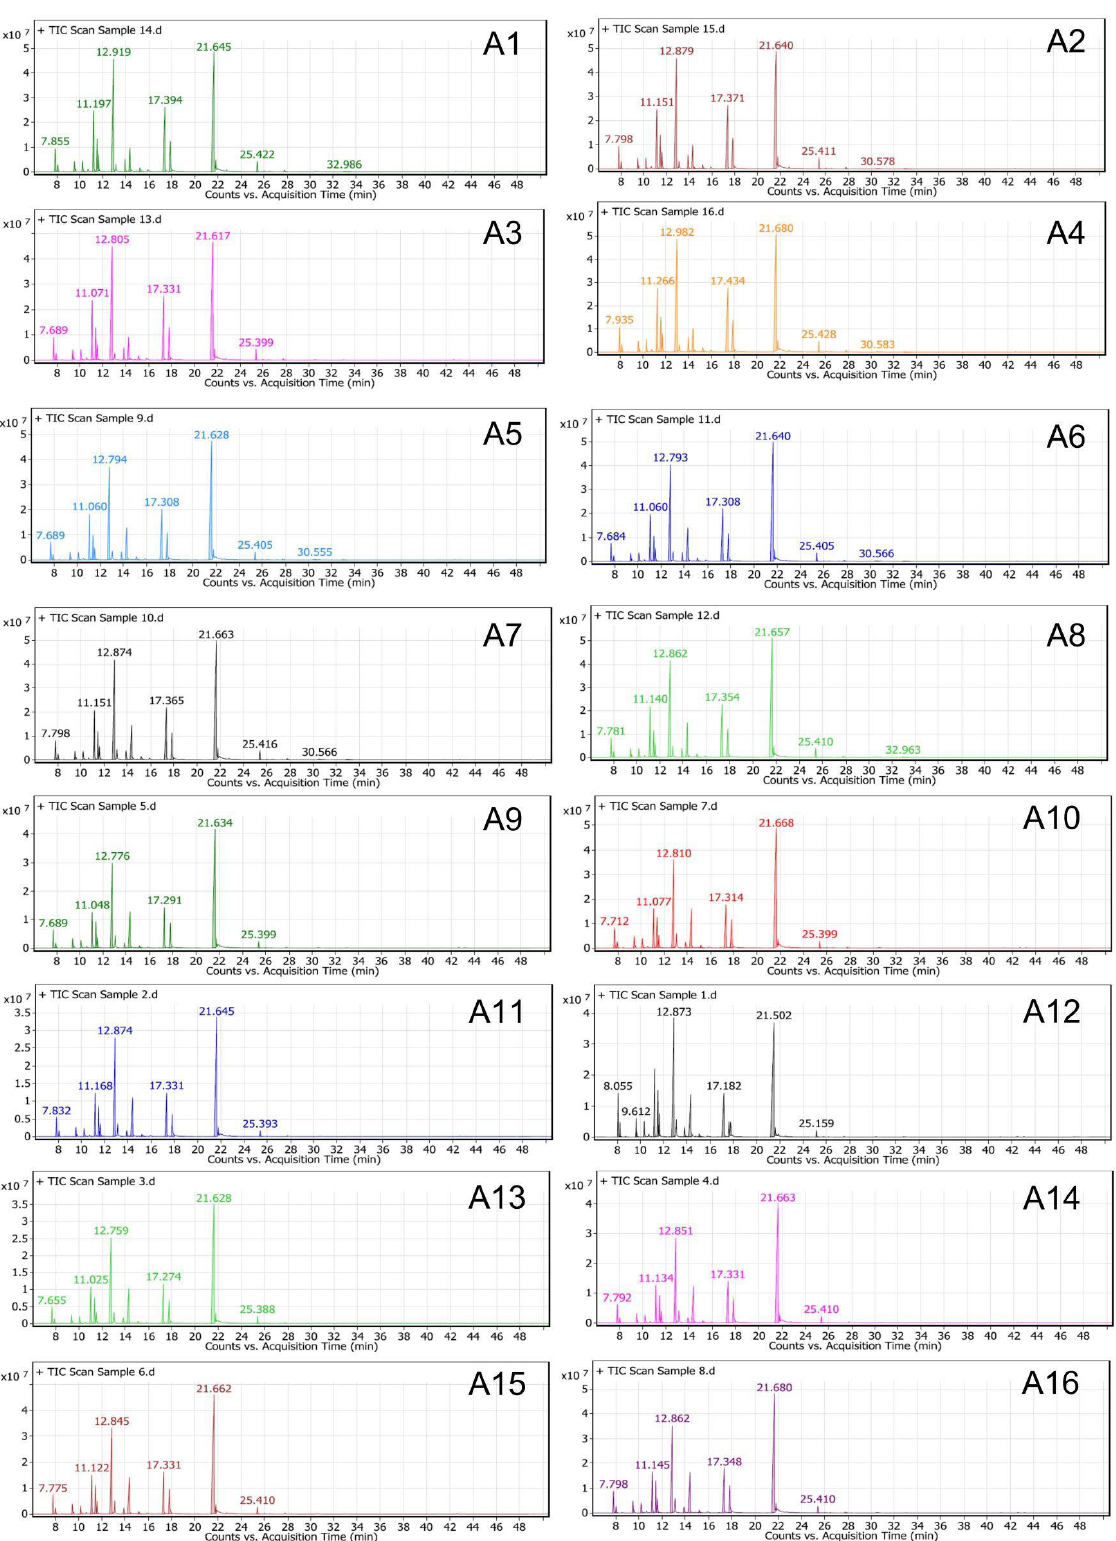
Figure 4: Total Ion Chromatograms (TIC) of GC-MS analyses of oils extracted from T. vulgaris plants treated or not with bacterial endophytes (T11r, T13r, and their consortium) under different mineral fertilization doses. The description of symbols A1 to A16 was recorded in the material and method